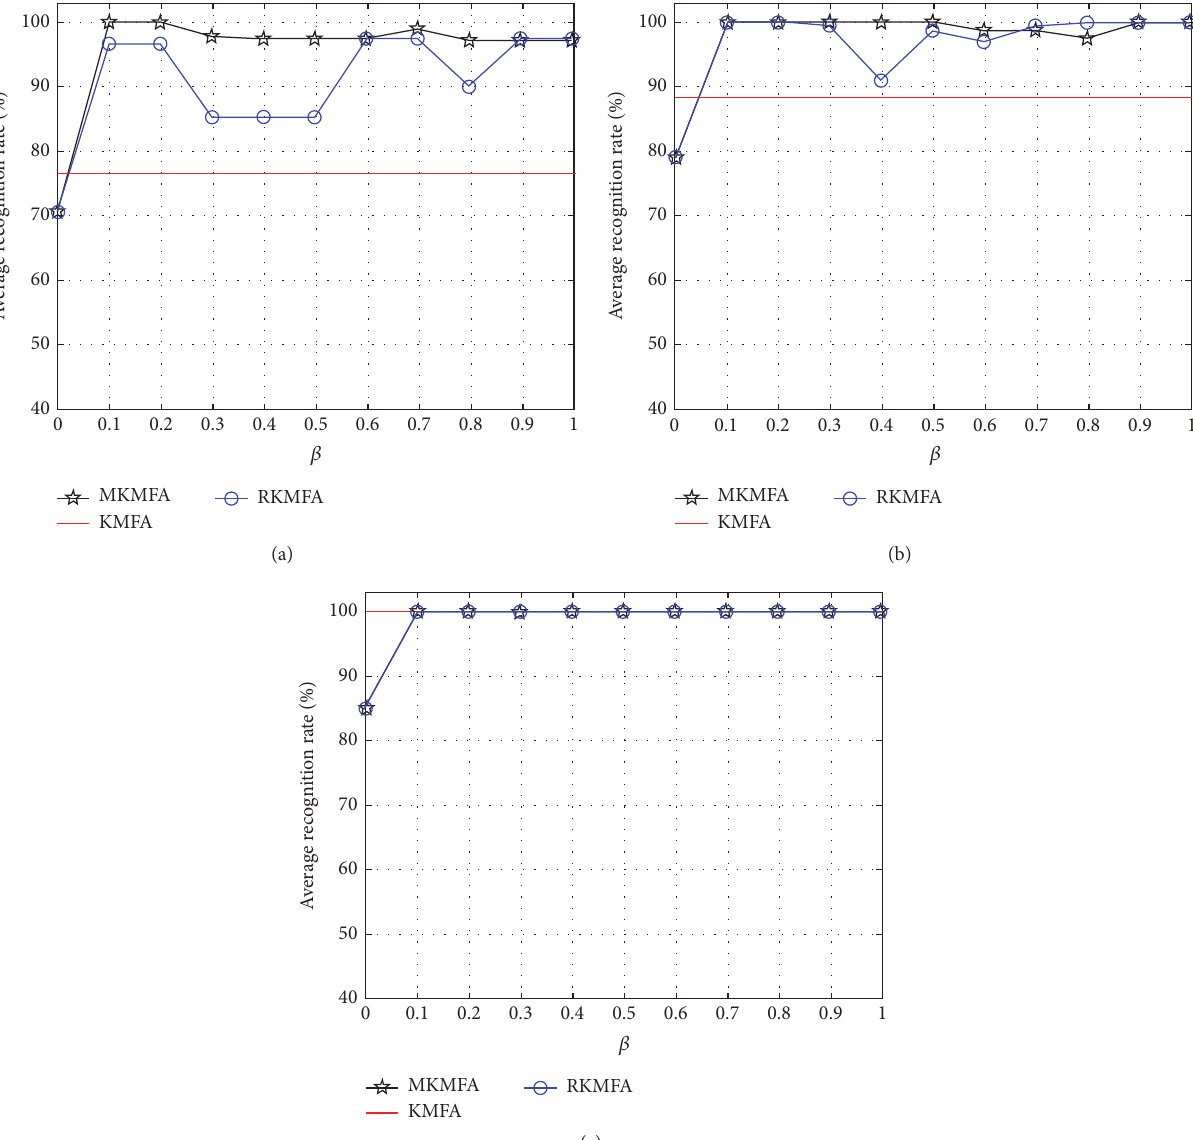
𝑙 𝑓 is the mean